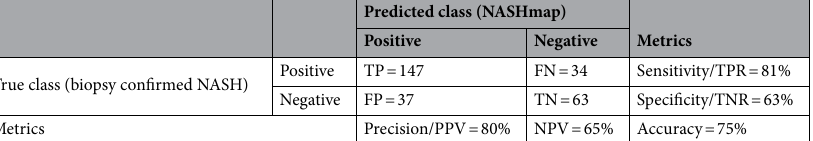
Table 2. Performance of NASHmap in classifying patients in a cohort with known status from NIDDK. Accuracy: TP + TN/(TP + FP + FN + TN); FN: false negative; FP: false positive; NIDDK: National Institute of Diabetes and Digestive Kidney Diseases; NASH: nonalcoholic steatohepatitis; NPV: negative predictive value (TN/[FN + TN]); PPV: positive predictive value (TP/[TP + FP]); TN: true negative; TNR: true negative rate (TN/[FP + TN]); TP: true positive; TPR: true positive rate (TP/[TP +